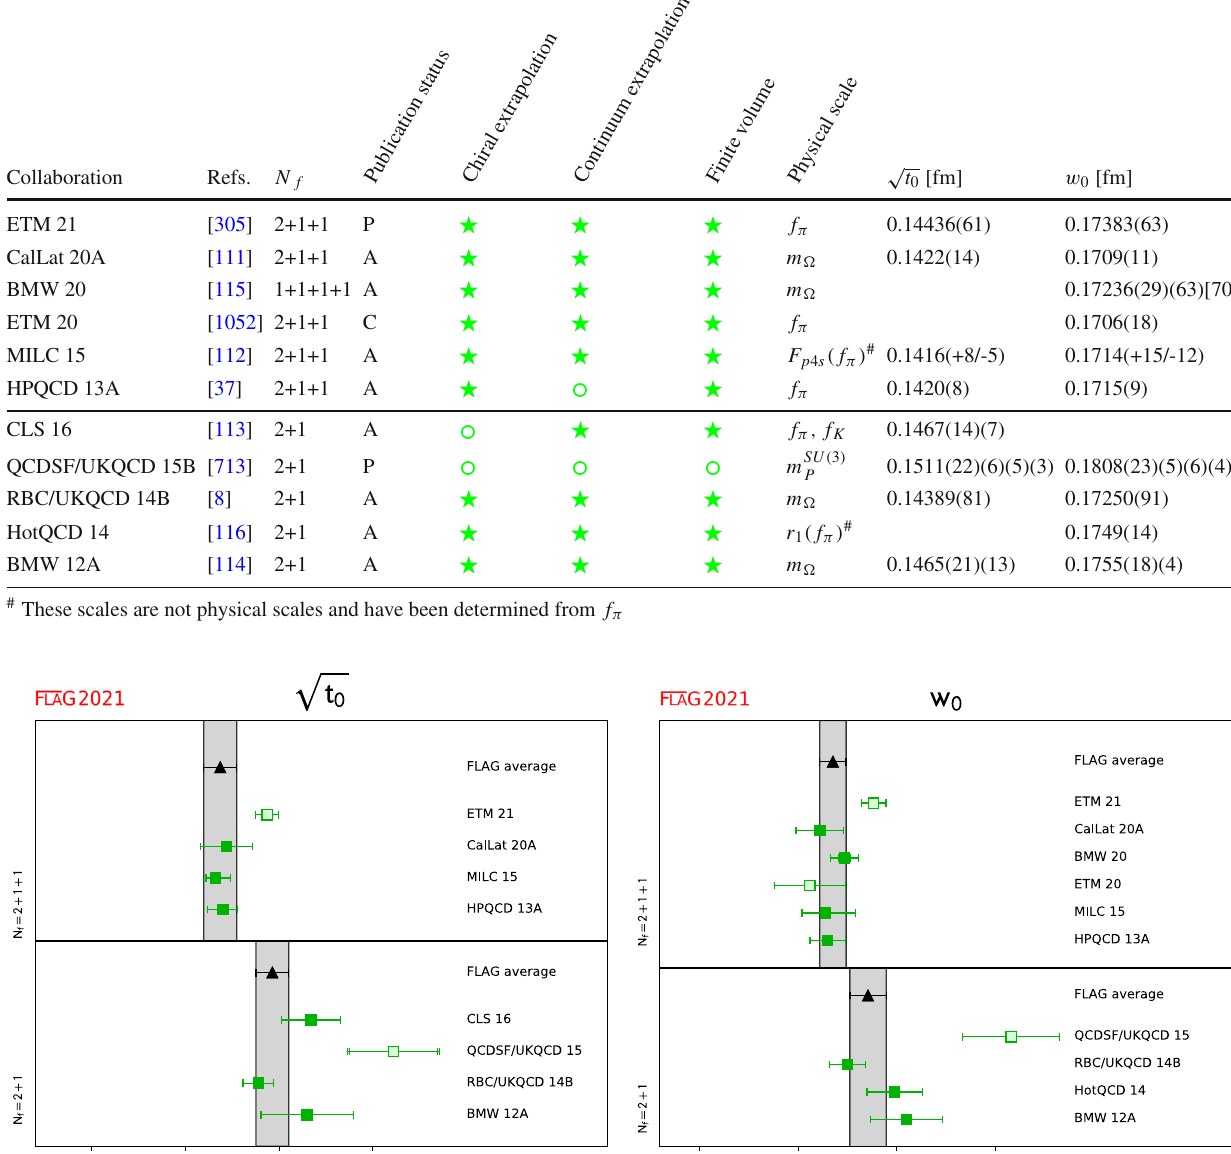
Fig. 51 Results for gradient flow scales